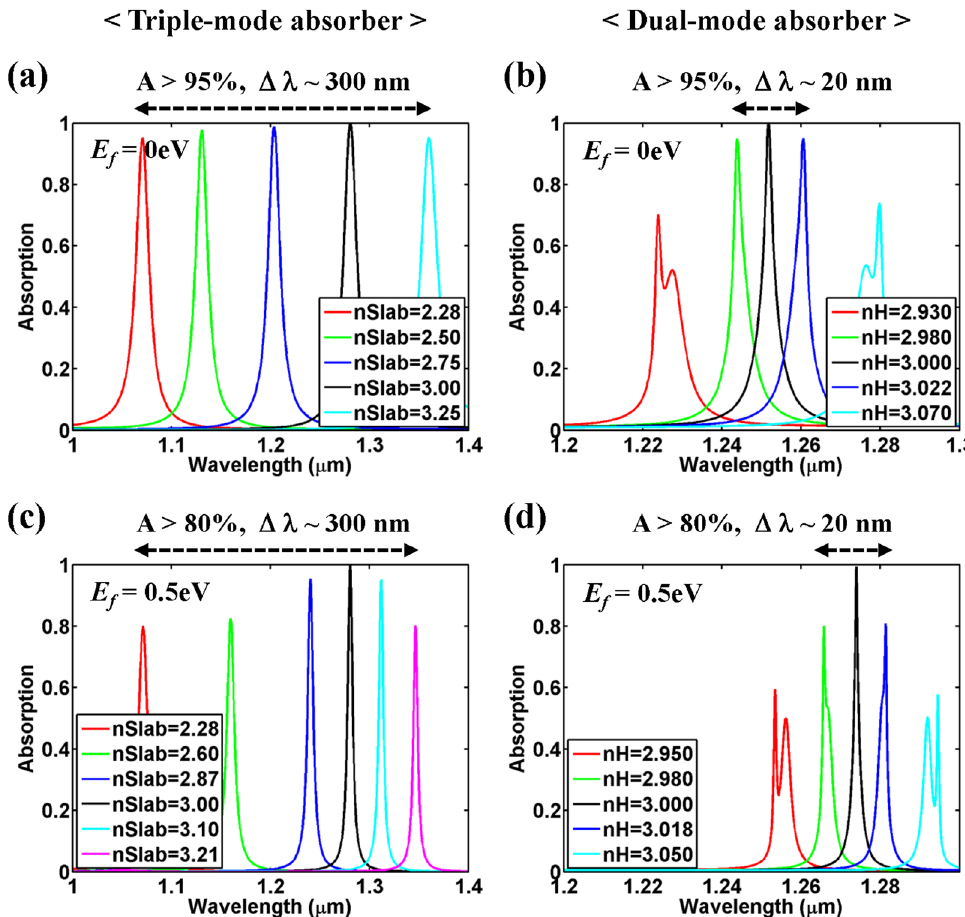
Figure 6. ( a ) Tunable absorption by adjusting n Slab for the proposed “ triple - mode absorber ”, assuming that the remaining parameters are the same as the optimal conditions considered in Fig. 2(f); that is, Period = 0.9 μ m, FF = 0.43, d Grat = 0.32507 μ m, d Gap = 0.38691 μ m, d Slab = 0.057335 μ m, and E f = 0 eV. ( b ) Tunable absorption by adjusting